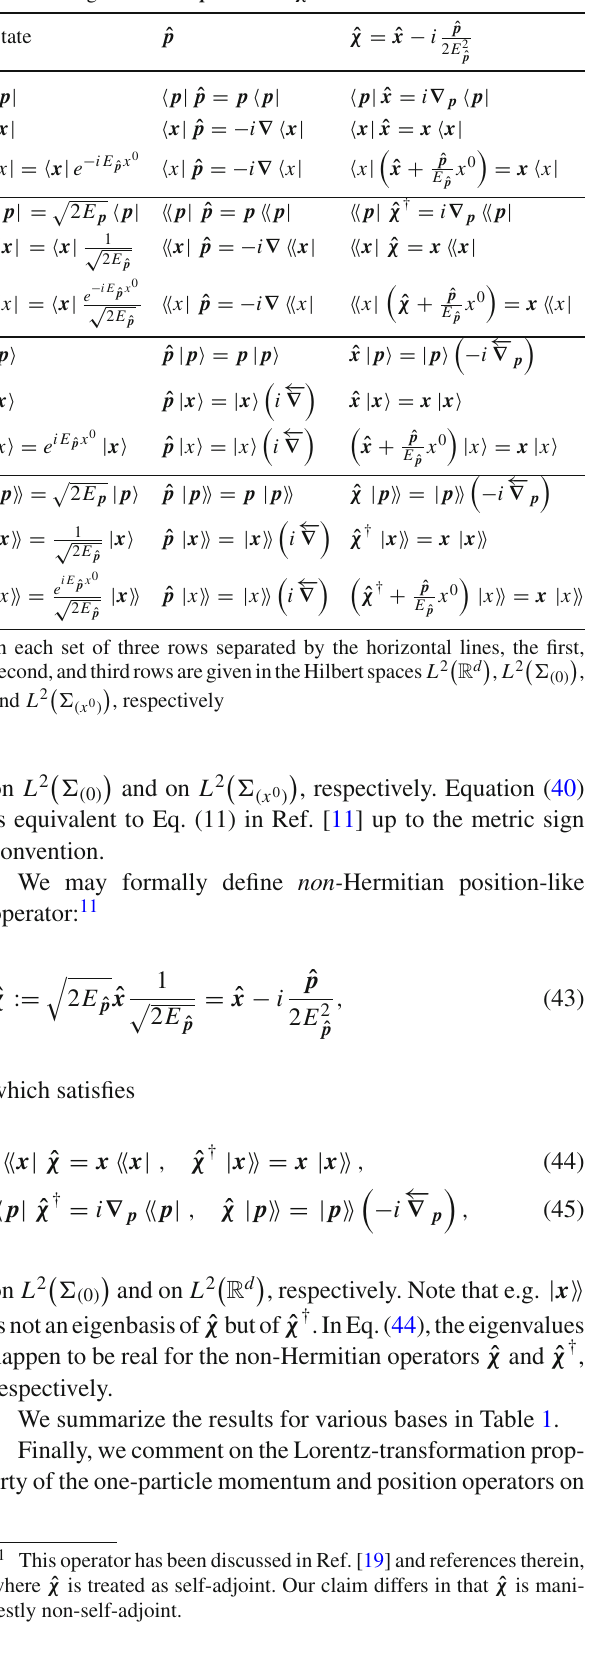
Table 1 Eigenvalues of ˆ p and ˆ x or ˆ χ on various